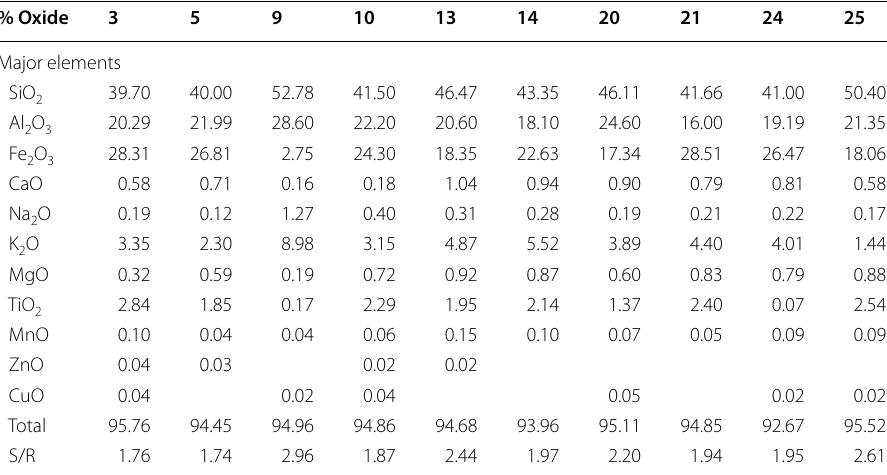
Table 4 Result of geochemical